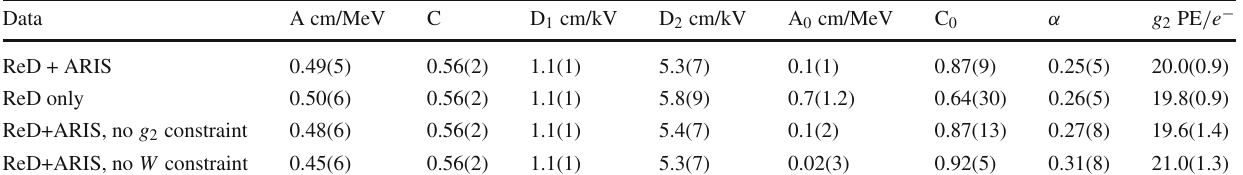
Table 2 Fit parameters for the modified Doke–Birks recombination model of Eq. 12 based on ReD and ARIS data. The value of the ioni- sation work function ( W ) is constrained to ( 23 . 6 ± 0 . 3 ) eV [38] for all